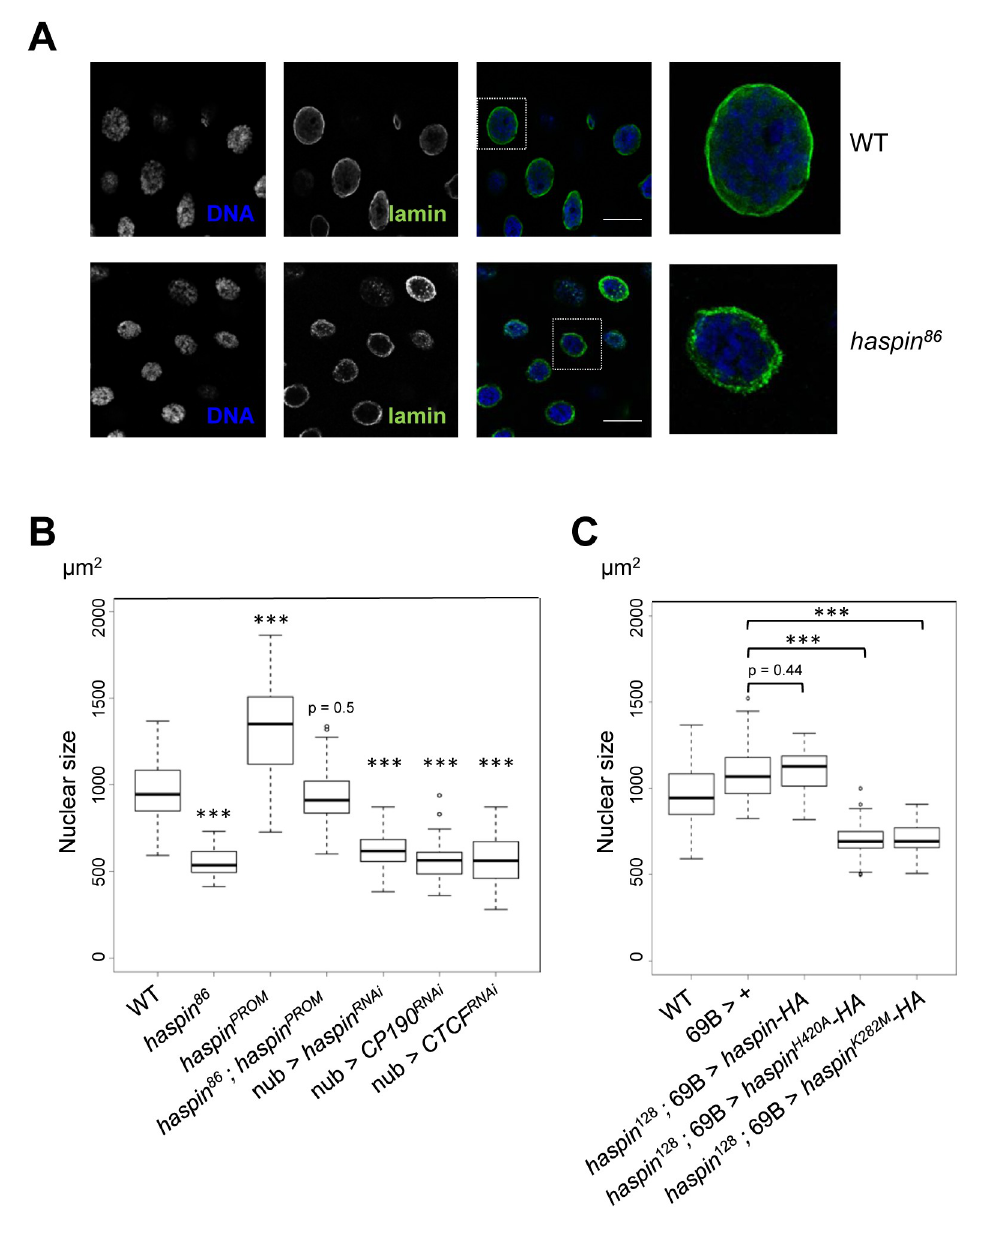
Fig 3. Modulation of nuclear architecture by haspin kinase. A) Immunostaining of Drosophila salivary glands with antibodies against lamin Dm0 in wild-type third-instar larvae (upper panel) and haspin 86 mutant background (lower panel). DNA is stained with DAPI. In the overlap (right panels), lamin Dm0 is shown in green and DAPI in blue. Scale bars are 50 μ m. B) Box plot showing quantification of DAPI signals of Drosophila salivary gland nuclei in wild-type (WT), haspin mutant background ( haspin 86 ), overexpression of haspin under control of its own promoter ( haspin PROM ), overexpression of haspin in a mutant background ( haspin 86 ; haspin PROM ) and in haspin, CP190, and CTCF RNAis under the control of nubbin promoter (nub > haspin RNAi , nub > CP190 RNAi , and nub > CTCF RNAi ). Nuclear size was determined in around 50 nuclei for each condition (n � 3). The p values as determined by Wilcoxon test of the different genetic backgrounds respect to WT are indicated ( ��� p < 0.001). C) Box plot showing quantification of DAPI signal of Drosophila salivary gland nuclei in wild-type (WT) and overexpression under the control of 69B of tagged versions of either haspin wild-type ( haspin-HA ) or haspin with a mutated kinase domain ( haspin H420A -HA and haspin K282M -HA ). Nuclear size was determined in around 50 nuclei for each condition (n � 3). Significant differences between wild-type and mutated kinase domains as determined by Wilcoxon test ( ��� p <